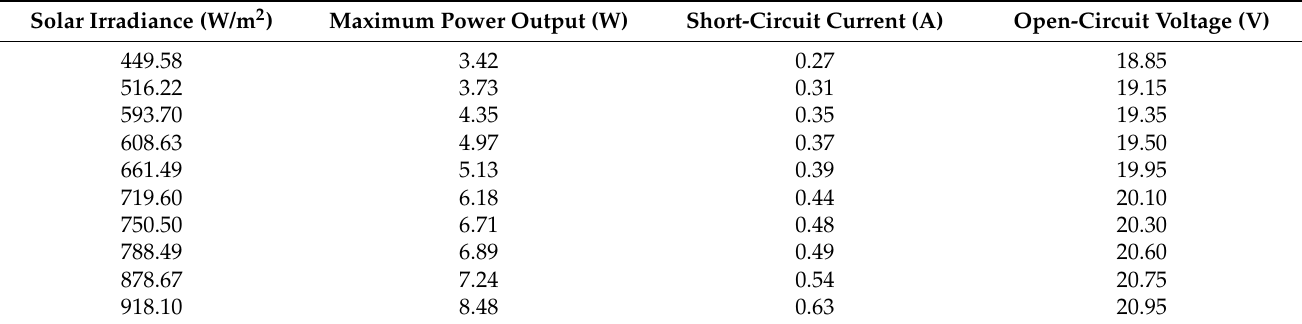
Figure 5. Prediction of output power of solar PV panel using different ML algorithms for Fold-3. 5. Establishing the Relationship between Solar Radiation and Short-Circuit Current The yield response of the PV panel was recorded for 10 different values of solar irradiance, i.e., 449 W/m 2 , 516 W/m 2 , 593 W/m 2 , 608 W/m 2 , 661 W/m 2 , 719 W/m 2 , 740 W/m 2 , 788 W/m 2 , 878 W/m 2 and 918 W/m 2 under different output load conditions, and their values are given in Table 4. Table 4. Yield value of the panel under different solar irradiance.